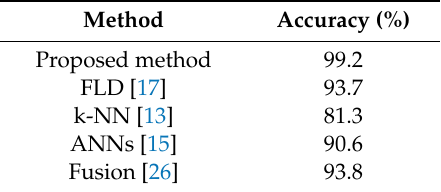
Table 5. Floor positioning accuracy comparison with other methods.